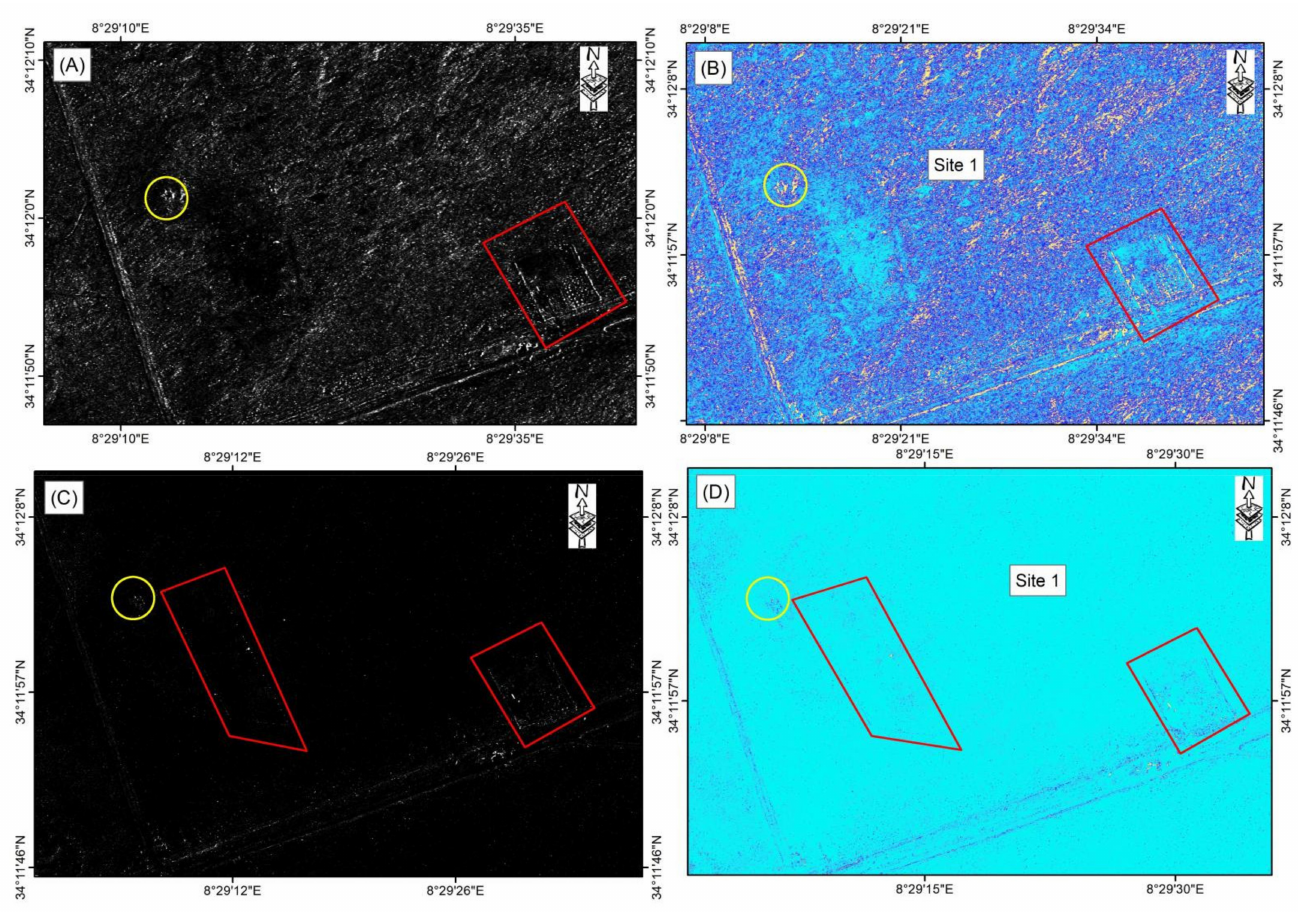
Figure 6. Identification of the archeological features of the ancient fortress (site 1) at Henchir BouG ô ra, Tunisia, from TSK ST data after application of the NL-SAR method. ( A ) High-resolution TSX ST-mode image of site 1 acquired on 20 February 2021 with a spatial resolution of 0.4 m under HH polarization at an incidence angle of 20.6 ◦ (© DLR, 2021); ( C ) high-resolution TSX ST-mode image of site 1